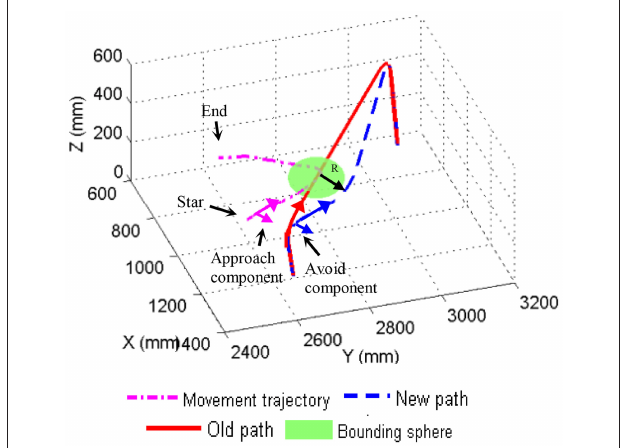
FIGURE 6 | The 3D trajectory.